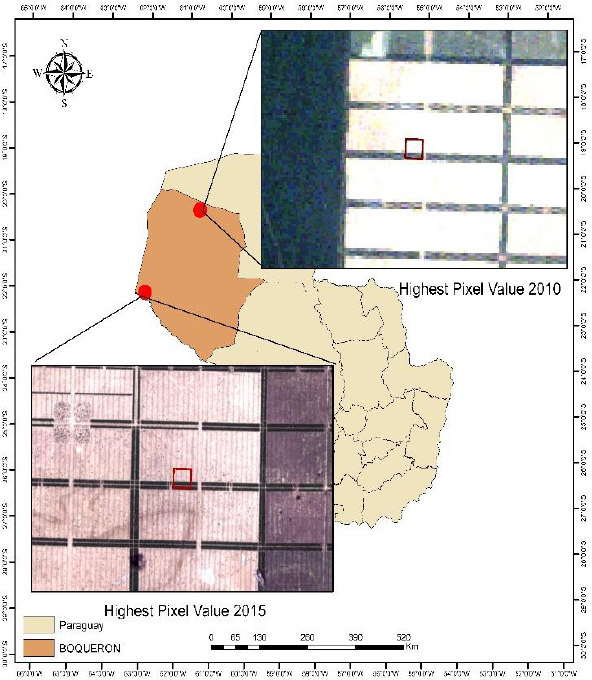
Figure 5. NDDI Drought based Map, year 2016.